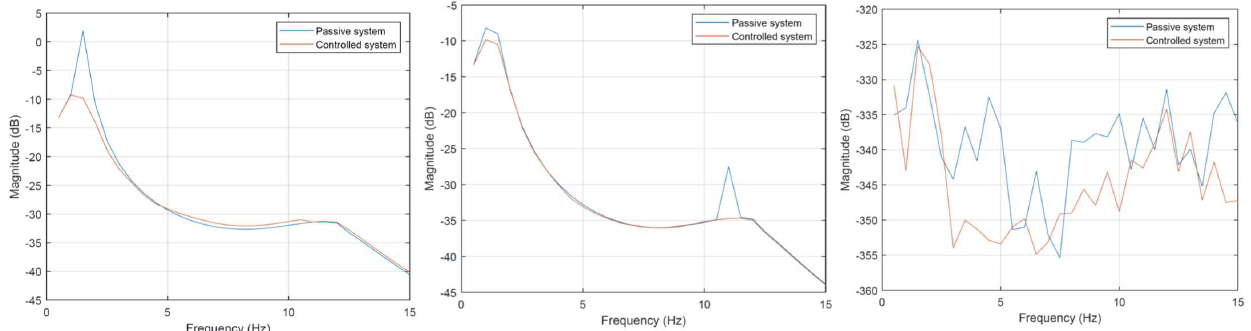
Figure 15. Vibration transmissibility characteristics for asymmetrical excitation of the front and rear axis, front wheel delayed by π/2, relative to the rear. Displacement of the center of mass—left characteristic, pitch angle—central characteristic, roll angle—right characteristic.